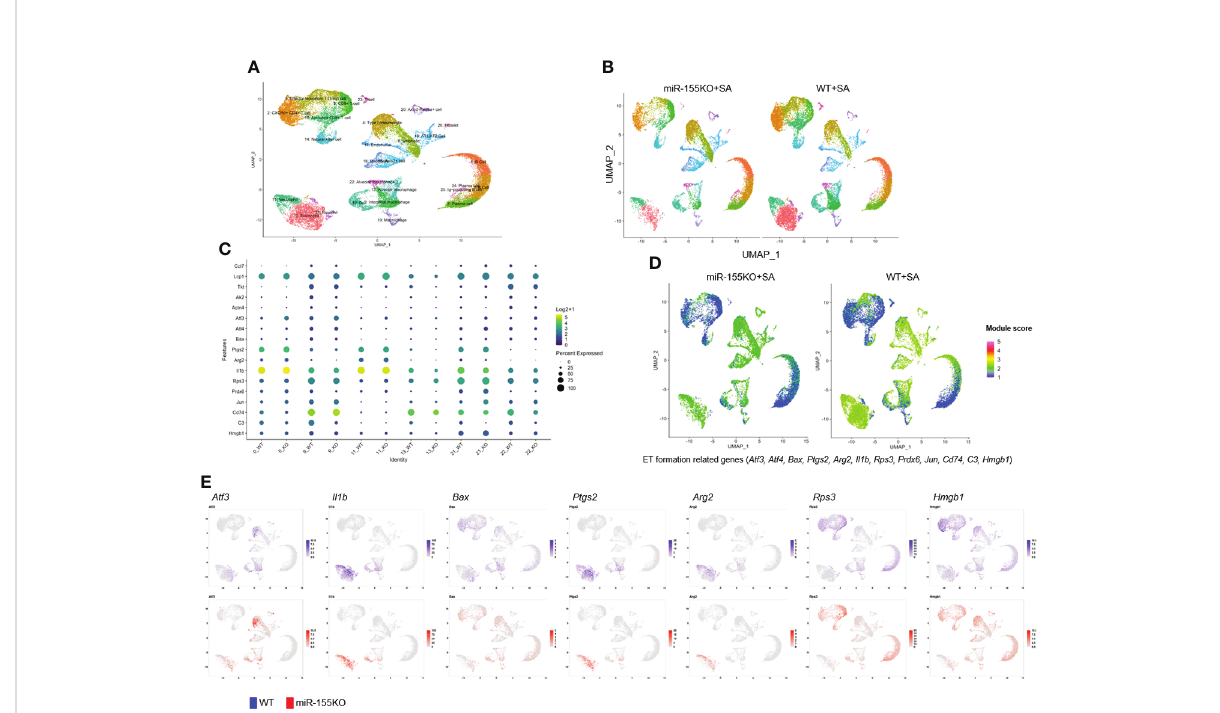
FIGURE 6 Single-cell RNA-seq analysis of the lung cells in severe asthma (SA) mice. (A) Single-cell RNA-seq was performed on single-cell suspensions from whole lungs of mice. Cells were clustered using a graph-based shared nearest-neighbor clustering approach plotted by a UMAP plot. UMAP plot of all scRNA-seq data showing a total of 27 distinct cellular populations that were identi fi ed. (B) UMAP plots of lung cells from the miR-155KO and WT SA groups (N = 3 per group). All cells were analyzed using canonical correlation analysis with the Seurat R package. (C) The expression levels of ET formation-related Ccl7 , Lpc1 , Tkt , Ak2 , Actn4 , Atf3 , Atf4 , Bax , Ptgs2 , Arg2 , Il1b , Rps3 , Prdx6 , Jun , Cd74 , C3 , and Hmgb1 genes are shown. Each dot size corresponds to the percentage of cells in the cluster expressing a gene, and dot color corresponds to the mean expression level for the gene in the cluster. (D) UMAP plots compare gene module scores between miR-155KO and WT SA mouse lungs using ET formation-related genes ( Atf3 , Atf4 , Bax , Ptgs2 , Arg2 , Il1b , Rps3 , Prdx6 , Jun , Cd74 , C3 , and Hmgb1 ). (E) UMAP plots show the expression of the indicated ET-related genes in each cluster. UMAP, Uniform Manifold Approximation and Projection; WT, wild type; ET, extracellular